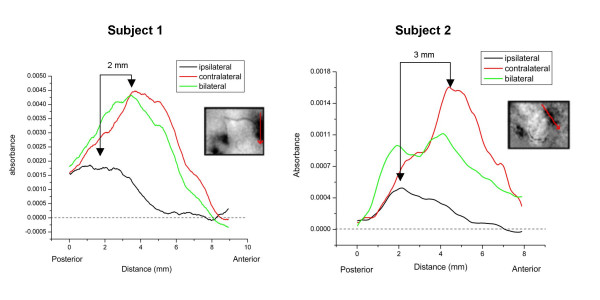
Spatial distribution of response along anterior-posterior axis of SII. Graphs obtained from OIS data in the anterior and posterior SII cortical regions evoked by flutter stimulus on the central pad of the two subjects shown in Figure 1. Orientation of segmentation indicated by figurines. Left Panel: Note that the response evoked by the bilateral stimulus is slightly smaller than the response evoked by the contralateral stimulus in the anterior region but larger than the response evoked by the contralateral stimulus in the posterior region. Right Panel: Note that in this case, the absorbance values evoked by the bilateral stimulus is significantly smaller than the response evoked by the contralateral stimulus in anterior SII, but approximates a summation of the ipsilateral and contralateral responses in posterior SII. The range of the responses to bilateral stimulation in anterior SII is typified by these 2 subjects – though the differences between the bilateral and contralateral response ranged from small (as in subject 1) to large (as in Subject 2) the bilateral response under the conditions studied were weaker than the contralateral response for all subjects (n = 6).